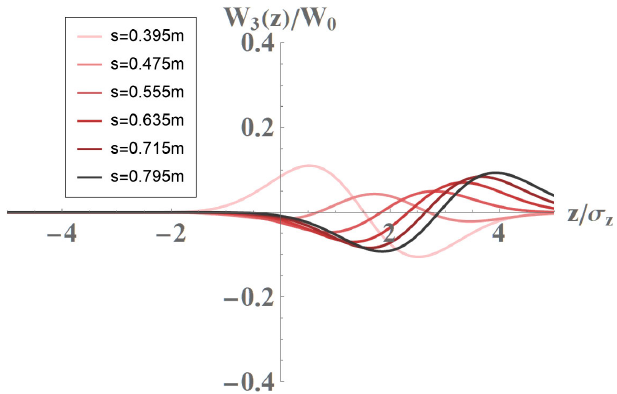
FIG. 19. Evolution of W 3 ð z Þ inside drift D2 in beamline D by theory prediction [See Eq. (106)]. The wake eventually attenuates for large s